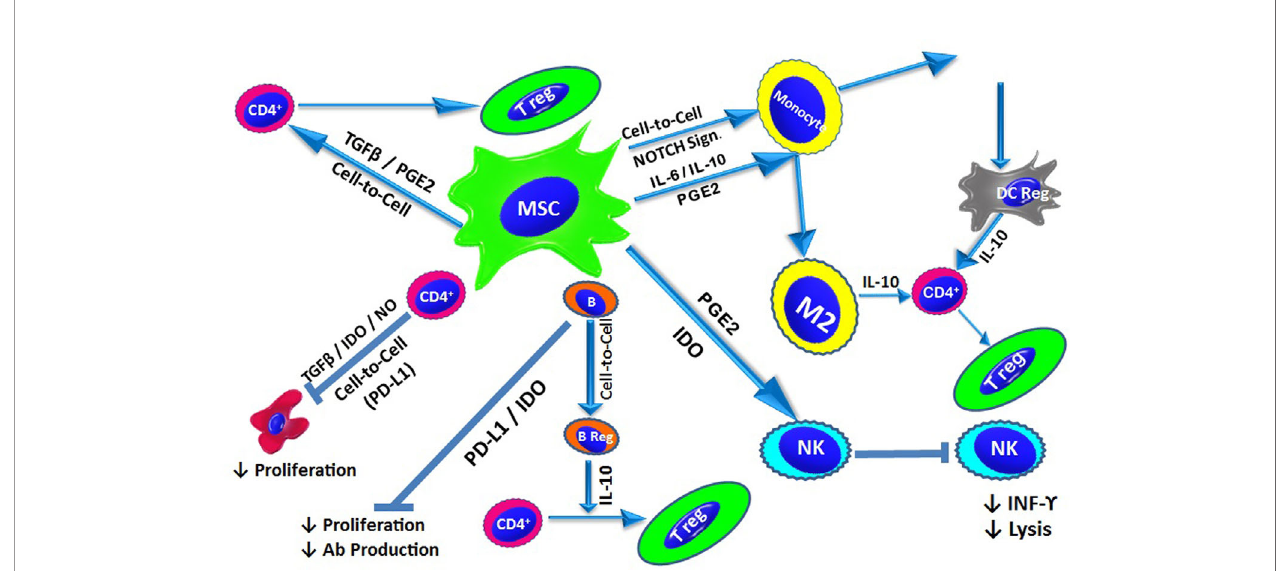
FIGURE 2 | MSC-Mediated Immunomodulation: Under in fl ammatory conditions, MSCs exert their immunomodulatory effect via cell-to-cell contact and/or the release of soluble factors. In addition to contact-dependent inhibition, MSCs suppress T cell proliferation by secreting IDO, NO and TGF- b . MSCs also modulate naïve T cells to generate Tregs through cell-to-cell contact, as well as via TGF- b and PGE2. B cell proliferation and antibody production is inhibited by IDO and PD-L 1 . Through direct interactions, MSCs also promote the generation of IL-10-producing Bregs. MSCs affect the innate immune system and suppress NK cell proliferation and cytokine secretion, a process mediated by IDO and PGE2. MSCs also inhibit the differentiation of monocytes into DCs via the release of IL-6 and IL-10. Additionally, MSCs can drive DCs towards an IL-10-producing tolerogenic phenotype through the activation of Notch signalling. MSCs also direct macrophages towards an anti-in fl ammatory phenotype (M2) via the action of IL-10. IL-10 production from via different pathways triggers the generation of